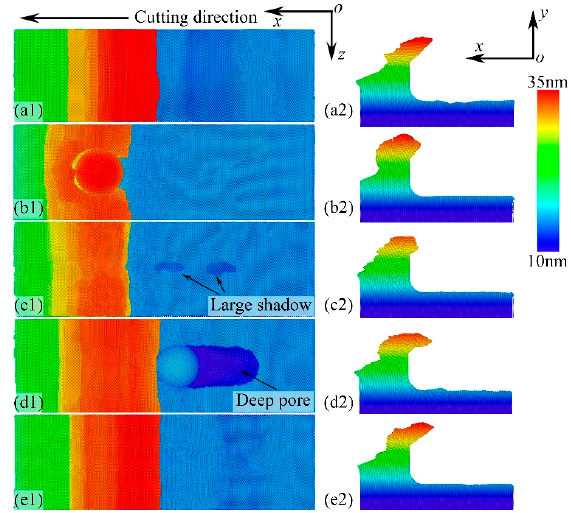
Figure 5. Machined surface quality of the workpiece with no NPs ( a ), with NP for ∆ D = 4 nm ( b ), 2 nm ( c ), 0 nm ( d ), and − 5 nm ( e ) under the workpiece free